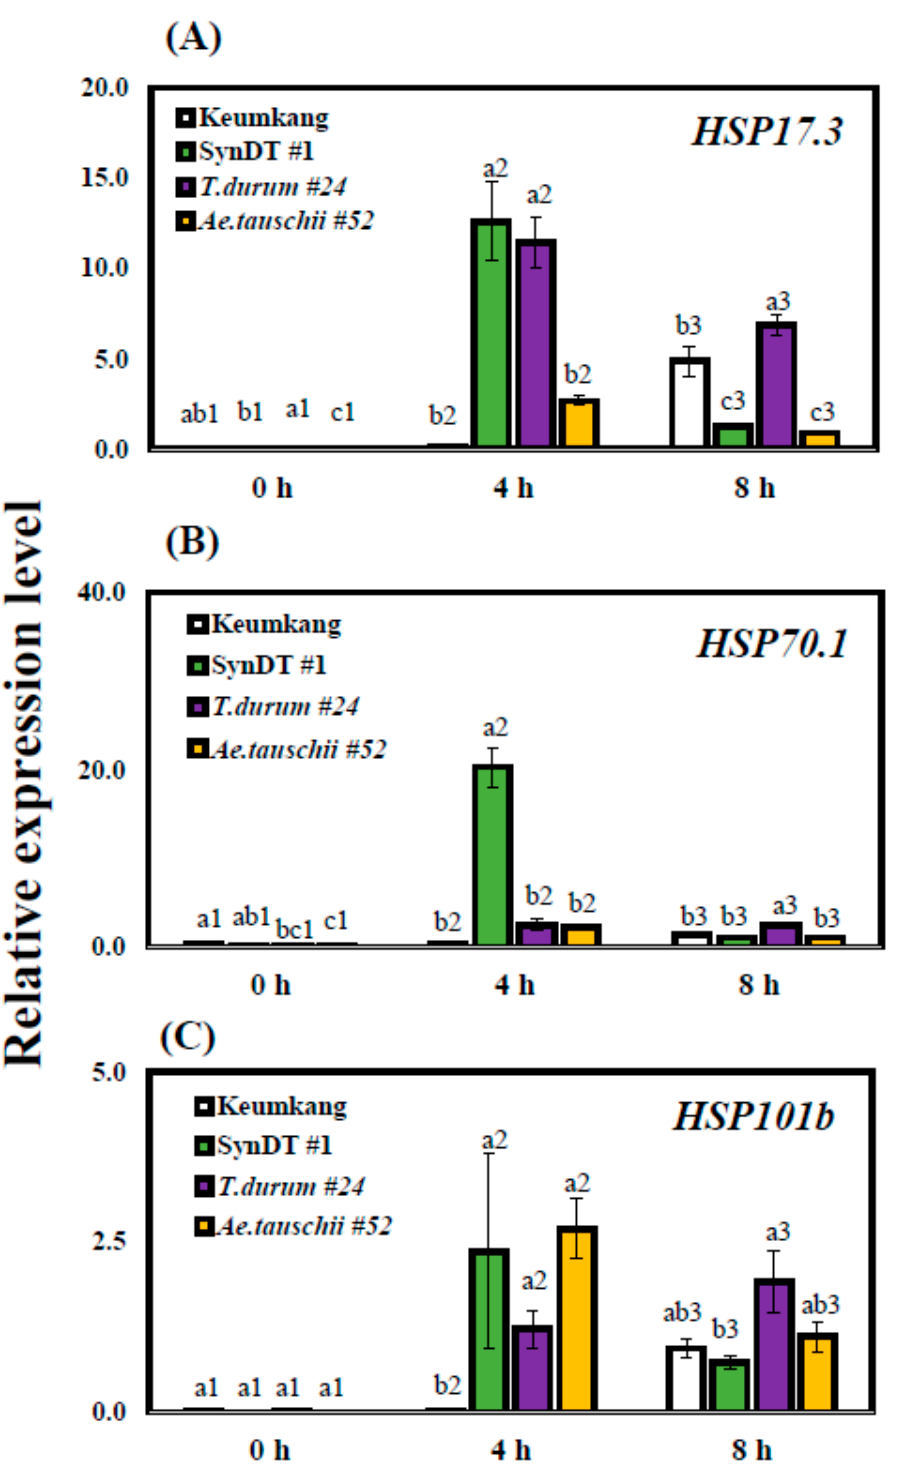
Figure 4. Transcript levels of HSP genes in response to HS . ( A ) HSP17.3 . ( B ) HSP70.1 . ( C ) HSP101b . Six-day-old wheat seedlings were exposed to HS at 45 ◦ C for 4 and 8 h. The samples were collected for RNA extraction and cDNA synthesis. Actin97 was used as the internal control. The experiments were conducted at least twice to verify that the results were consistent. Standard deviation value was calculated from three replicates in each treatment. One-way ANOVA and Tukey’s test ( α = 0.05) were performed using SAS. Different letters (a, b, or c) indicate significant differences ( p < 0.05).